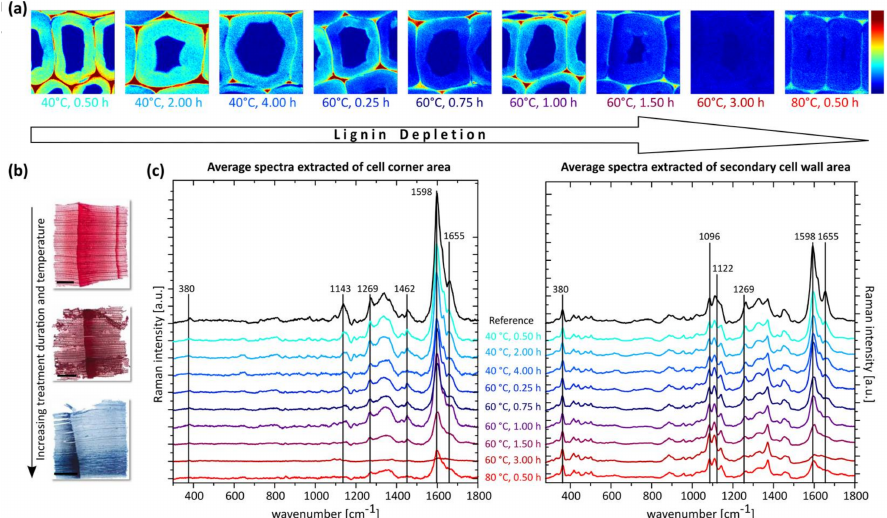
Figure 2. Characterization of acidic bleached spruce wood cross sections. ( a ) Raman images based on the integration of the main lignin band at 1598 cm − 1 (all images are identically scaled). ( b ) Staining of spruce wood cross sections (scale bar = 1 mm). ( c ) Calculated average spectra, extracted from the secondary cell wall region and cell corner area (all cell wall spectra are normalized on the band at 380 cm − 1